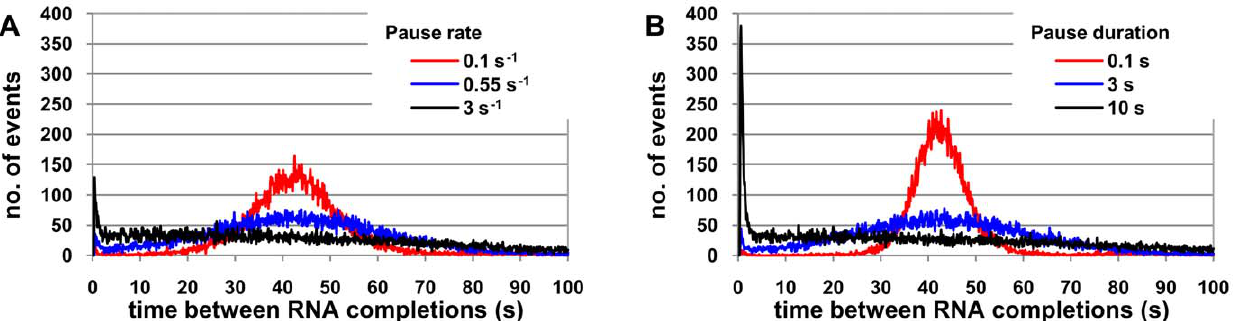
Figure 1. Pausing effect on the intervals between the production of consecutive RNAs. Intervals of successive RNA completions for (A) various rates of pausing and, (B) various average pause durations. The fraction of RNAs completed within intervals smaller than 5 seconds grows especially when increasing pauses mean duration (the black peak in 1B).